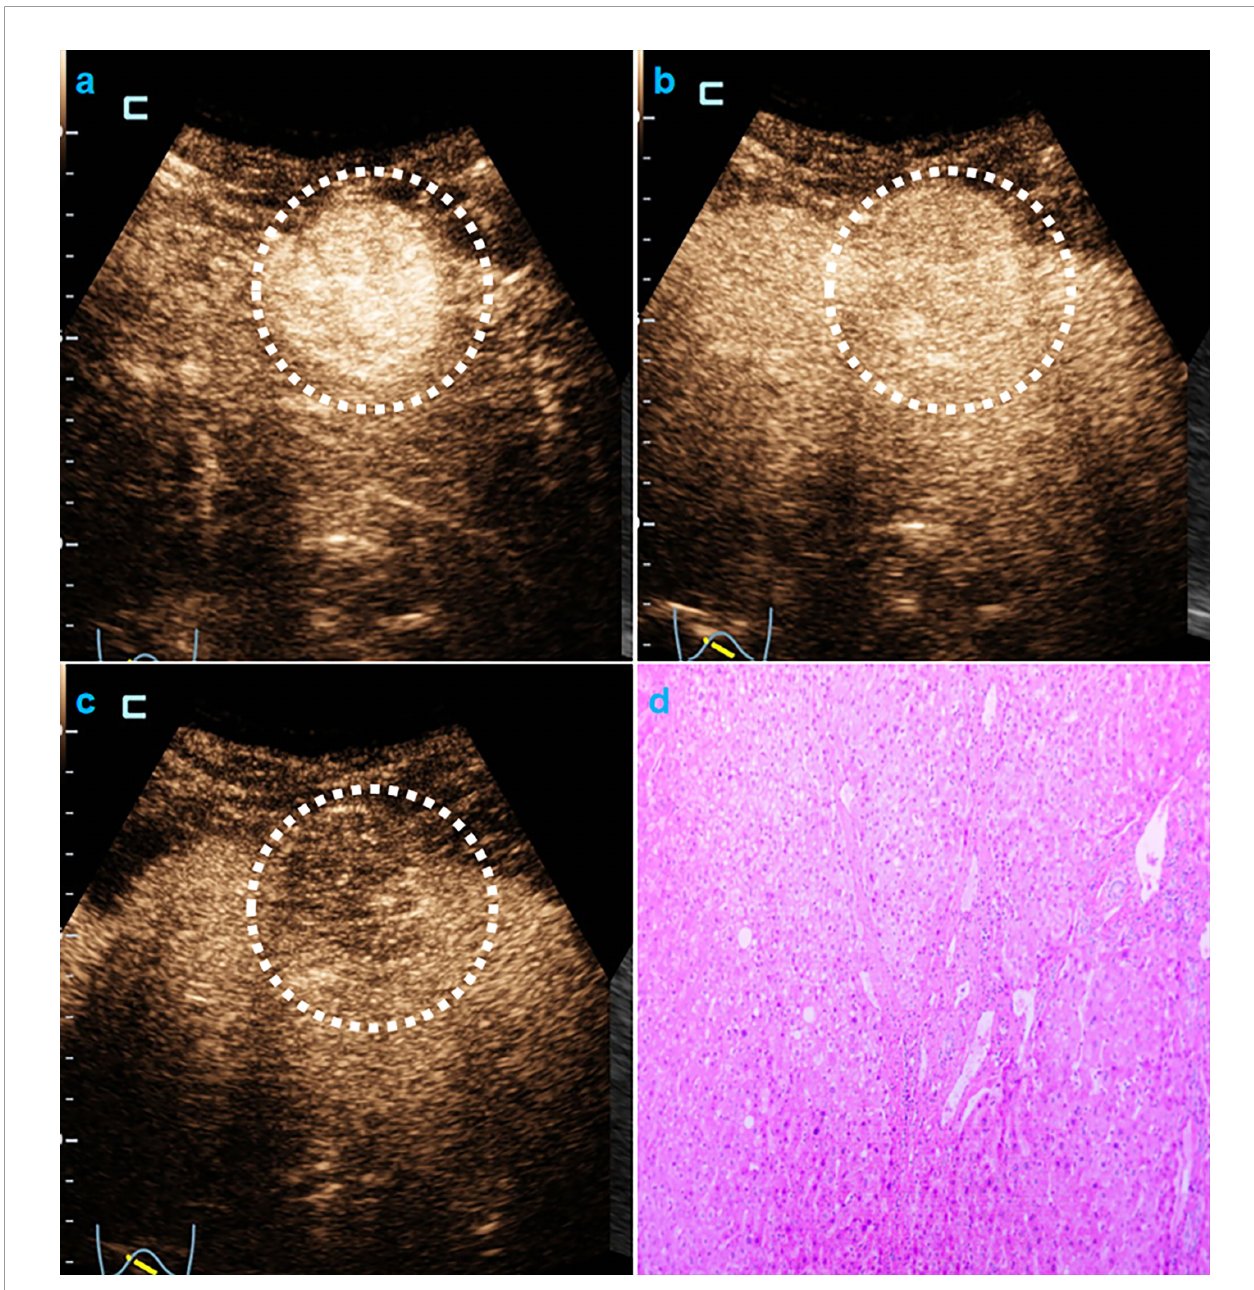
FIGURE 3 | CEUS LR-M and MVI-negative HCC. Male cirrhotic patient shows a 38.4mm HCC (AFP=1.8ng/mL) with arterial phase hyper-enhancement ( 22s, A ) early (44s, B ) and mild washout (120s, C ). The pathological specimen shows well-moderately differentiated HCC and absence of MVI (D)